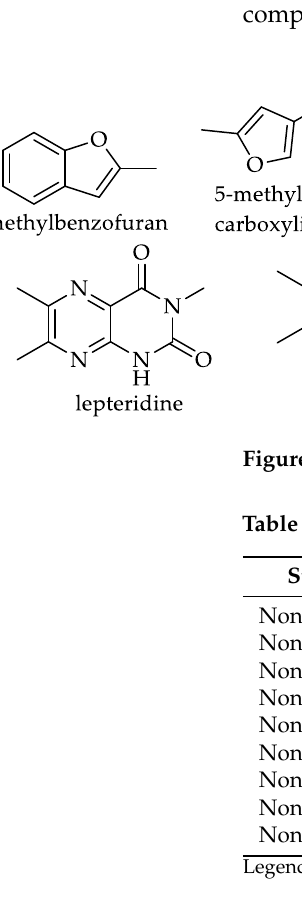
Table 15. Hydroxycoumarin, anthraquinone, naphthoquinone, stilbenes and benzyl oxalate ester reported in monofloral honeys.